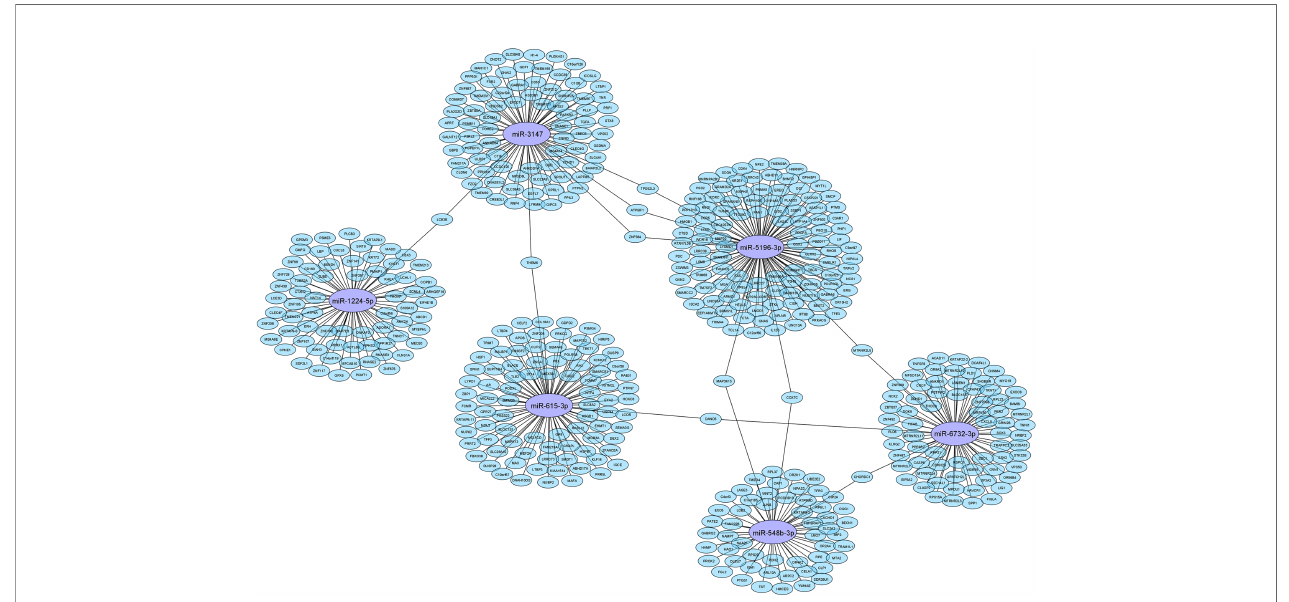
FIGURE 1 | Network of connection between tested miRNAs and their target genes.